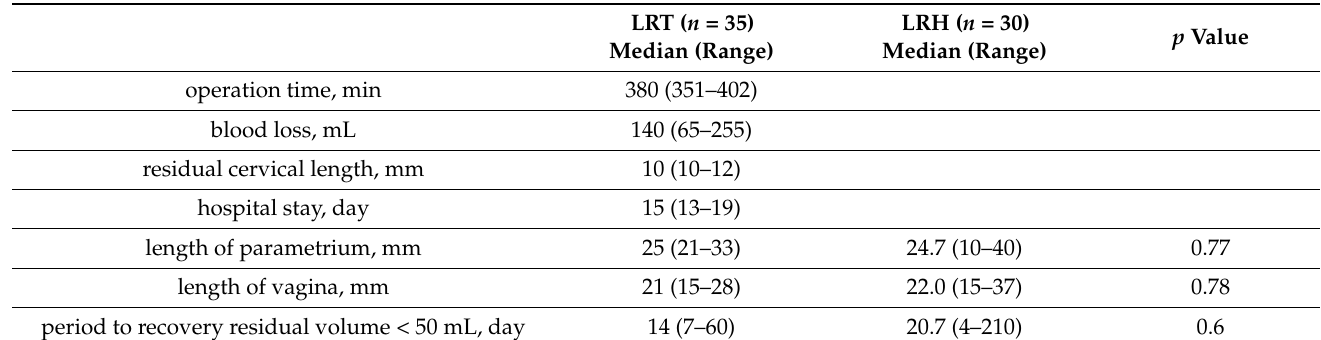
Table 2. Operative outcomes.